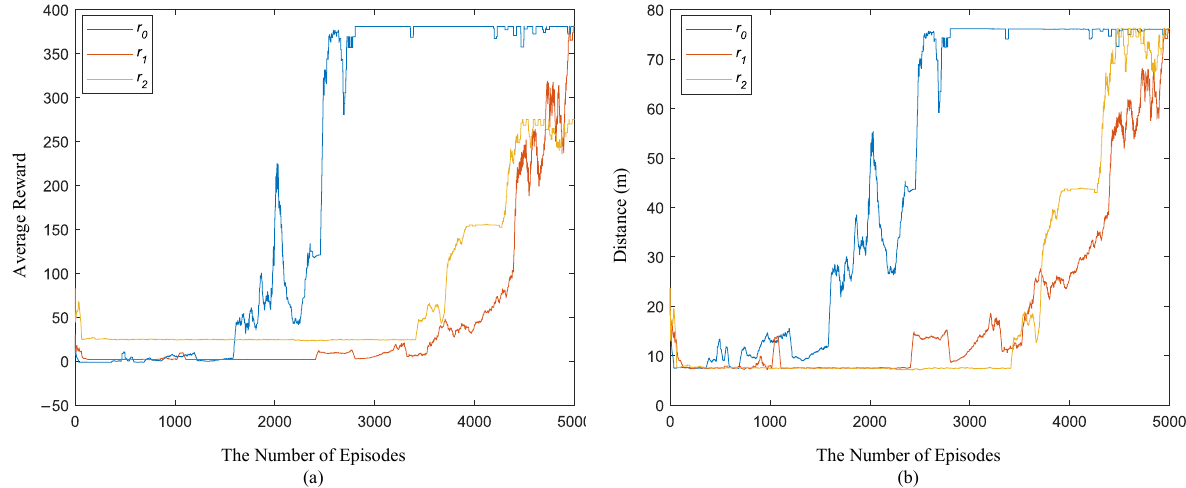
Figure 17. Comparison between different reward functions: ( a ) average reward of the last 30 episodes in the training process; ( b ) average maximum distance of the last 30 episodes.